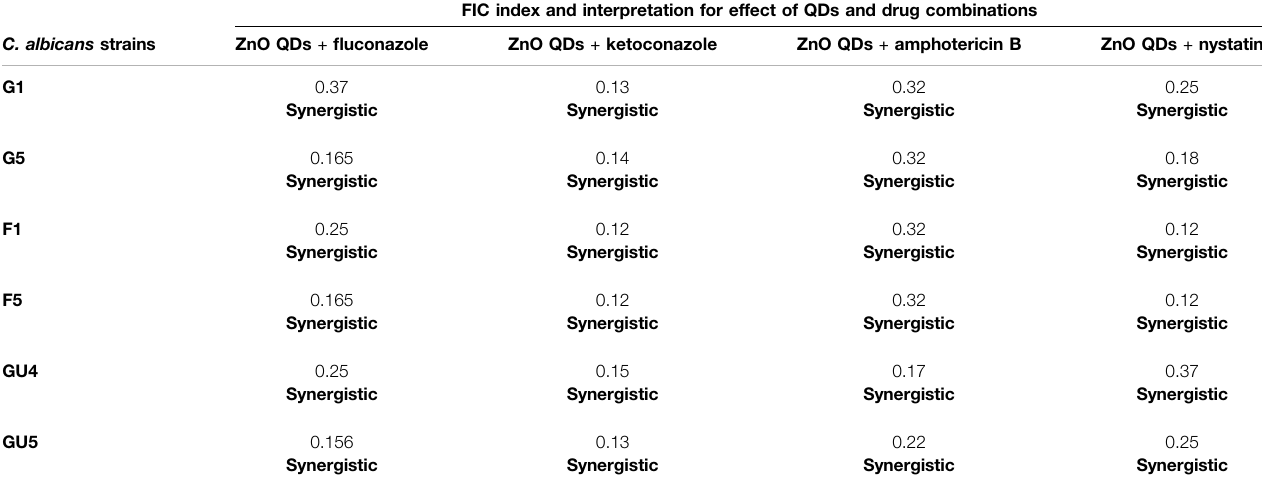
TABLE 3 | FIC index for different combinations of ZnO QDs and antifungal drugs tested against C. albicans strains. FIC index and interpretation for effect of QDs and drug C. albicans strains